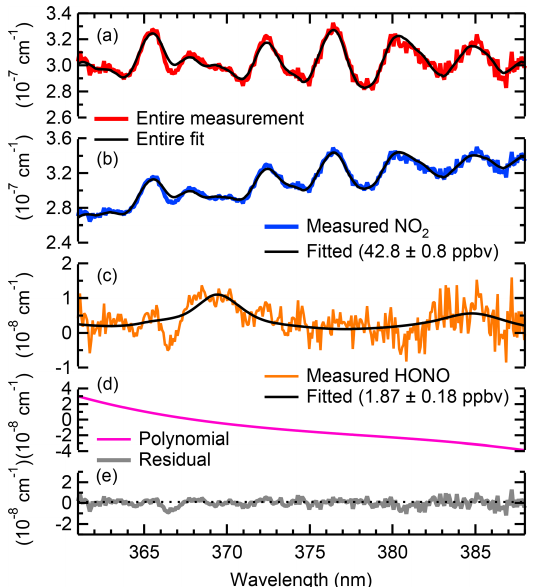
Figure 4. Sample fit of ambient air containing NO 2 and HONO sampled on 27 April 2018, at 01:00MST. Panel (a) shows the en- tire absorption spectrum. Shown in panels (b–d) are the absorption spectra of NO 2 and HONO with their respective fit errors and the polynomial. Panel (e) shows the fit